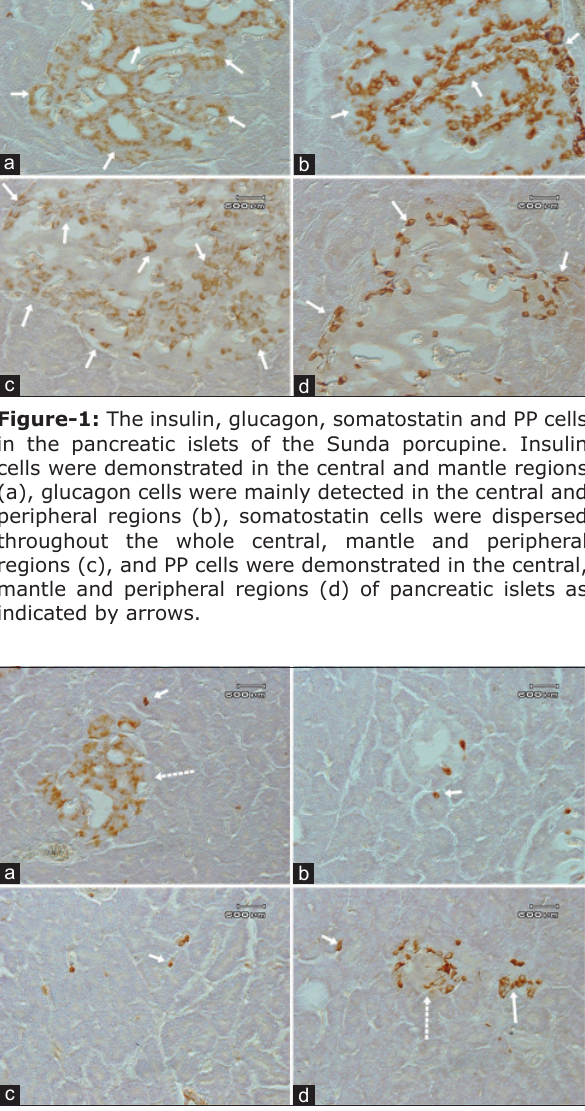
Figure-2: The insulin, glucagon, somatostatin and PP cells in the pancreatic acini of the Sunda porcupine. In the exocrine regions, insulin (a), glucagon (b), somatostatin (c) cell were detected between acinar cells, individually, while cluster of pancreatic polypeptide cells were detected between acinar cells (d) as indicated by solid arrows. Insulin (a) and pancreatic polypeptide cells were also detected in the small islets of Langerhans as indicated by discontinuous arrows.